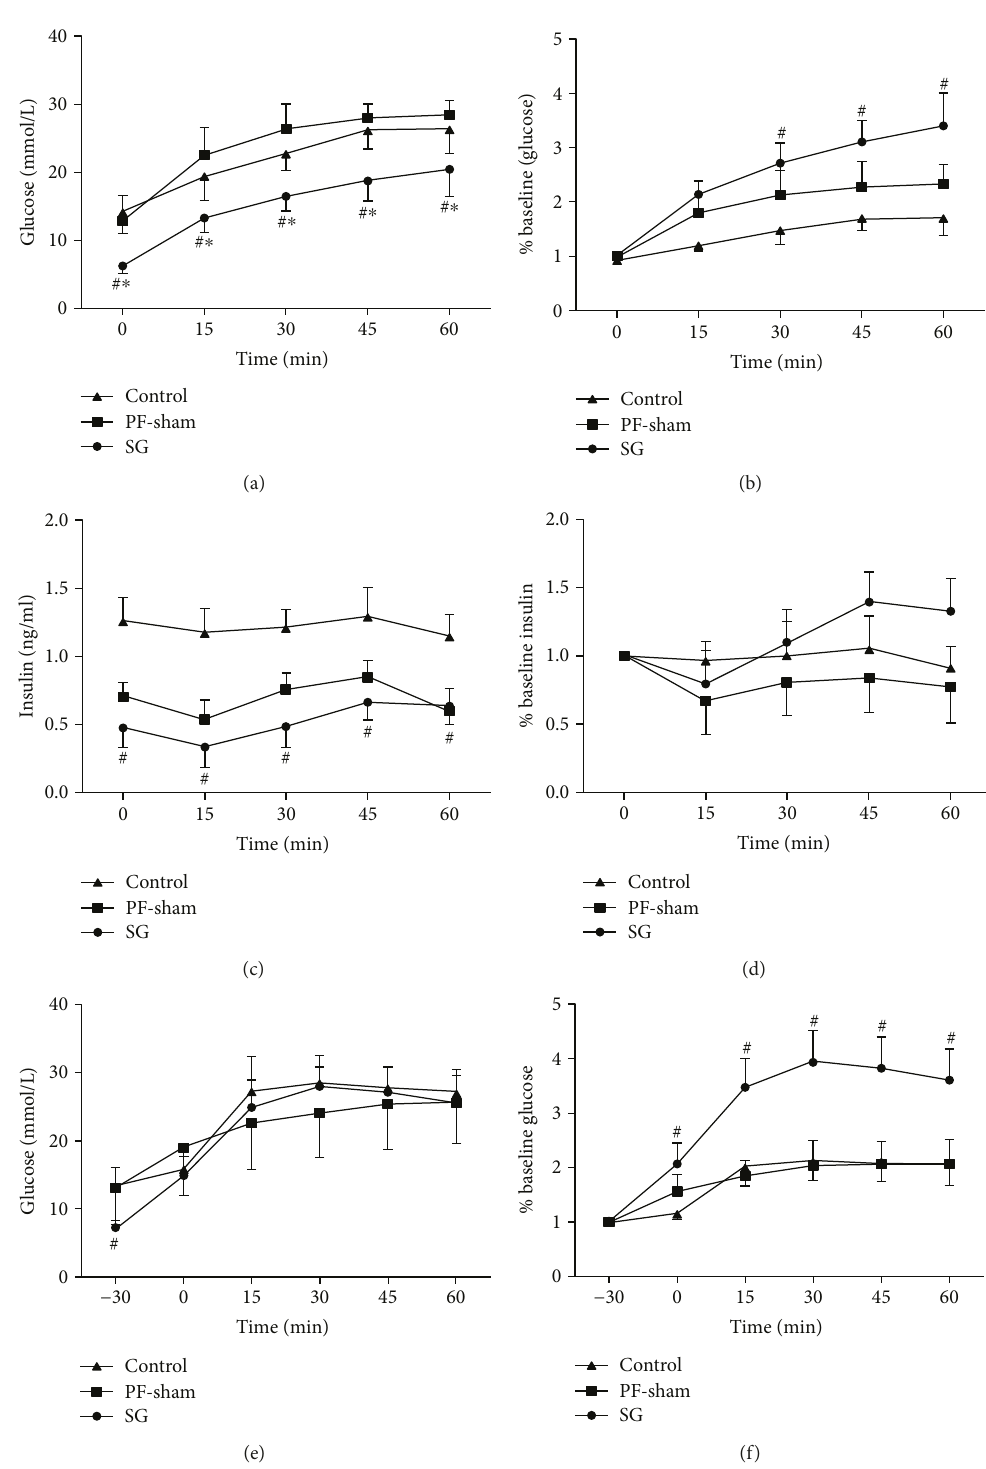
Figure 4: E ff ect of exendin (9-39) on glucose metabolism in GK rats. Line charts show the blood glucose level (a) expressed as a percentage of the baseline level (b) and insulin level (c) expressed as a percentage of the baseline level (d) after an IP injection of exendin (9-39). Blood glucose levels (e) expressed as a percentage of the baseline level (f) with an IP injection of exendin (9-39), 30min before the OGTT. # P < 0 05 versus the controls; ∗ P < 0 05 versus